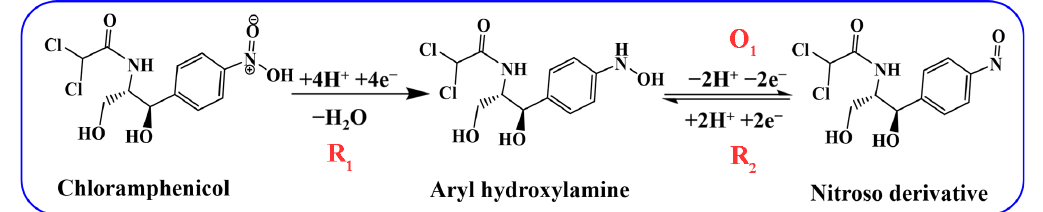
Figure 6. Electrochemical mechanism of CAP at PDPP/GO/GCE.